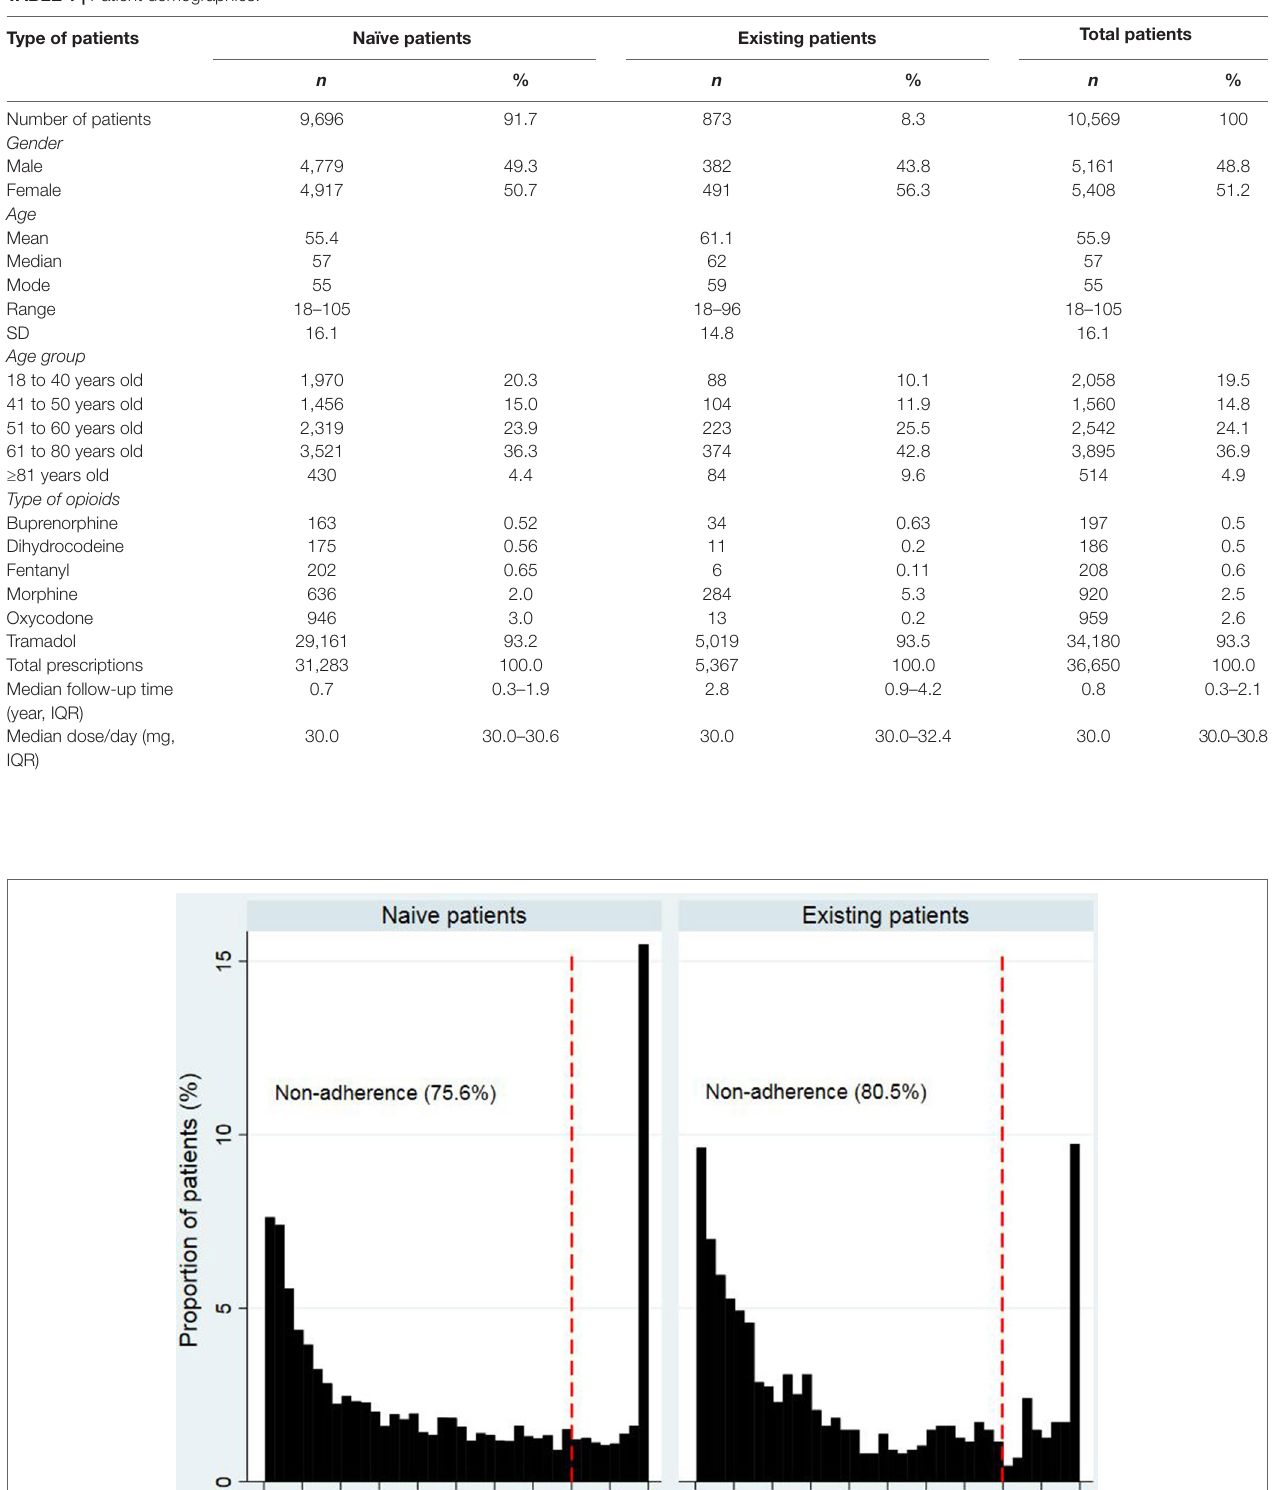
TABlE 1 | Patient demographics.